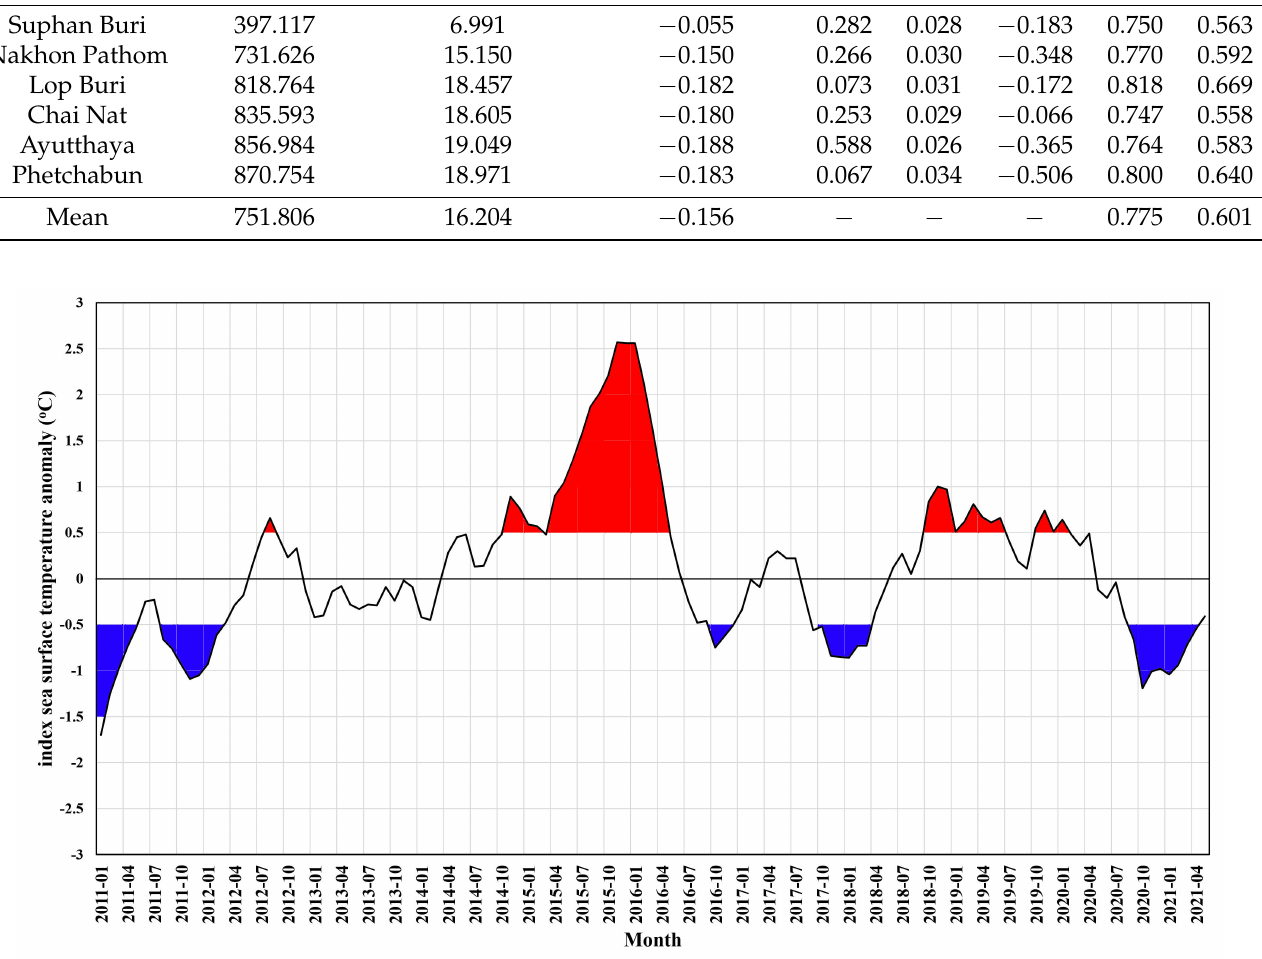
Figure 7. The occurrence of ENSO phenomena at Niño 3.4 (5 ◦ S–5 ◦ N, 170 ◦ W–120 ◦ W) regions from 2011 to